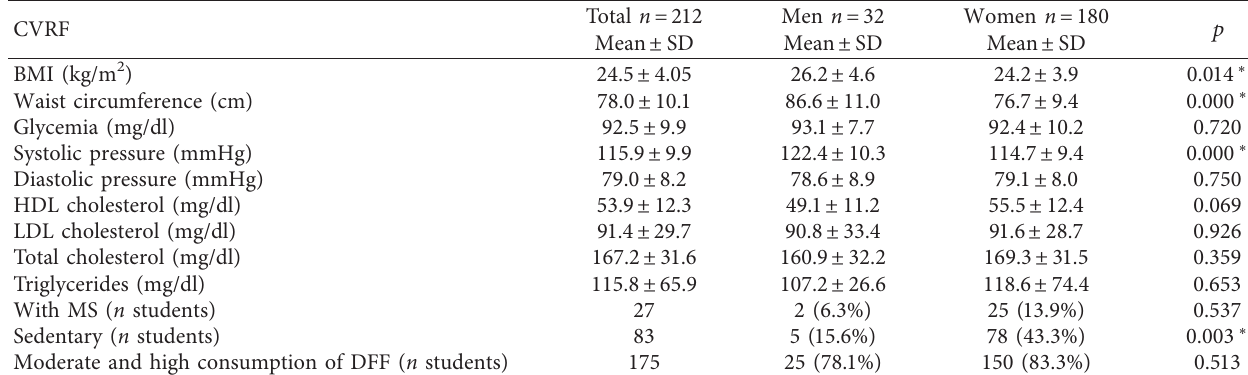
Table 2: Cardiovascular risk factors (mean +standard deviation) in the male and female students examined, in addition to the percentage of students with MS, sedentary, and moderate and high consumption of